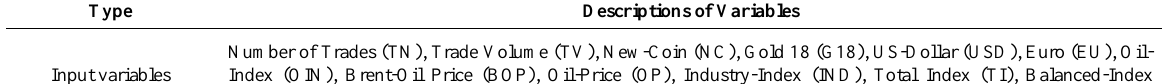
Table 1. Classification of collected data fields and their abbreviations used in modeling Type Descriptions of